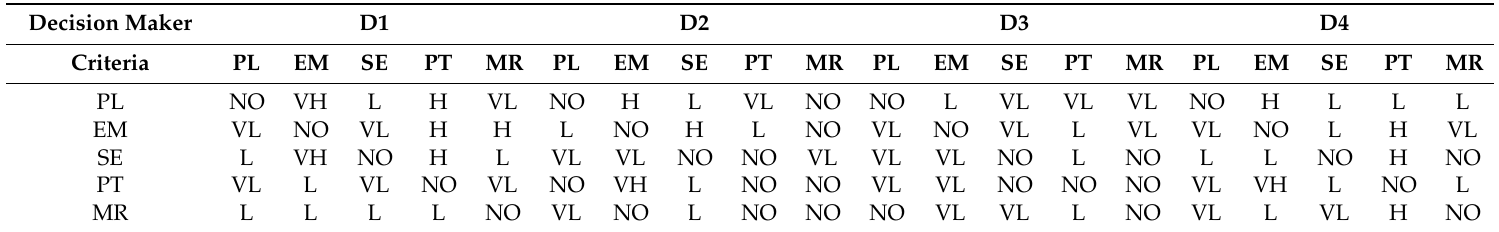
The initial direct-relation matrices by decision makers. PL—political/legal risk; EM—economic/market risk; SE—social/environment risk; PT—project/technical risk; MR—managing risk; NO—no influence; VL—very low influence; L—low influence; H—high influence; VH—very high